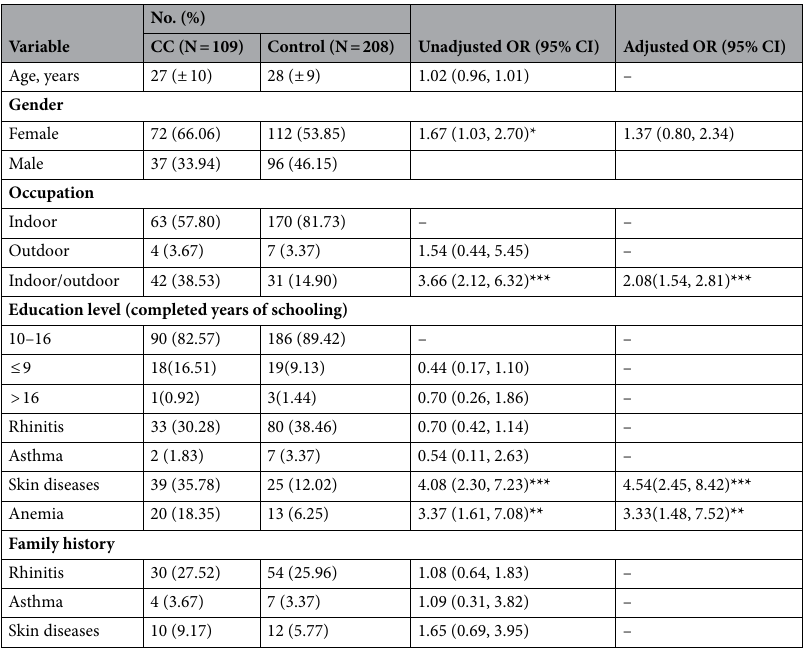
Table 3. Risk factors associated with chronic cheilitis. CC chronic cheilitis, OR odds ratio, CI confidence interval. * P < 0.05, ** P < 0.01, *** P <